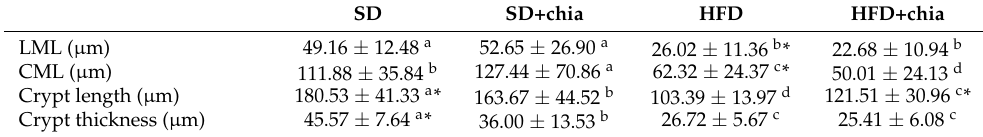
Table 4. Colonic histomorphometry characteristics of young Wistar rats after 35 days of treatment.